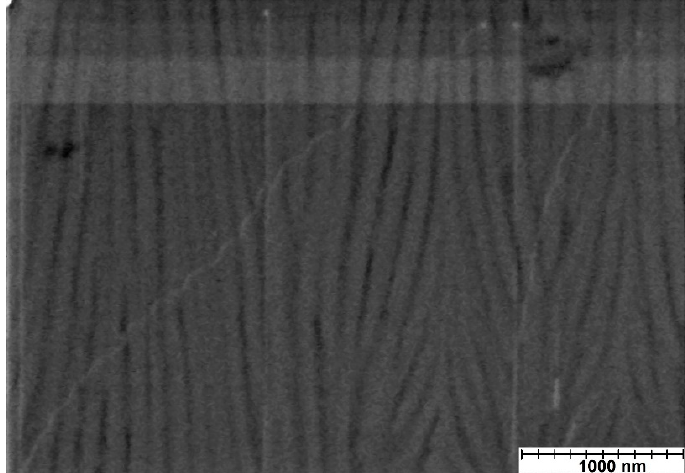
Figure 2. Microphotograph of oxide layer cross-section (sample